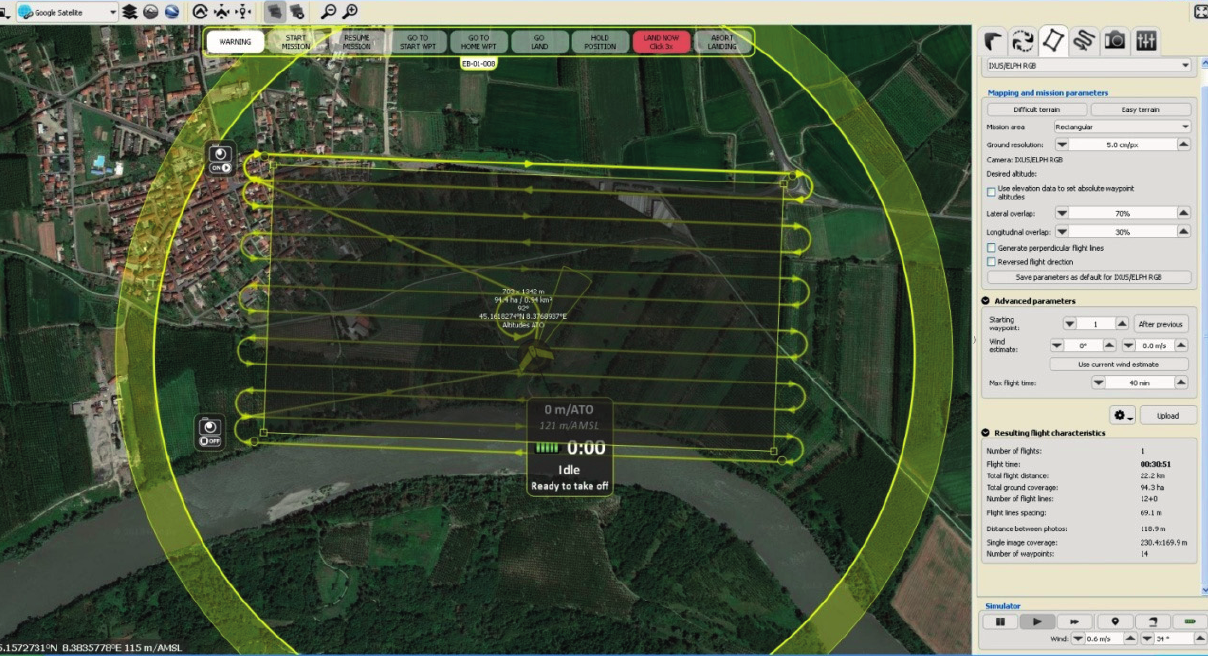
Figure 6. The fixed-wing RPAS flight plans: 150-m flight height above the